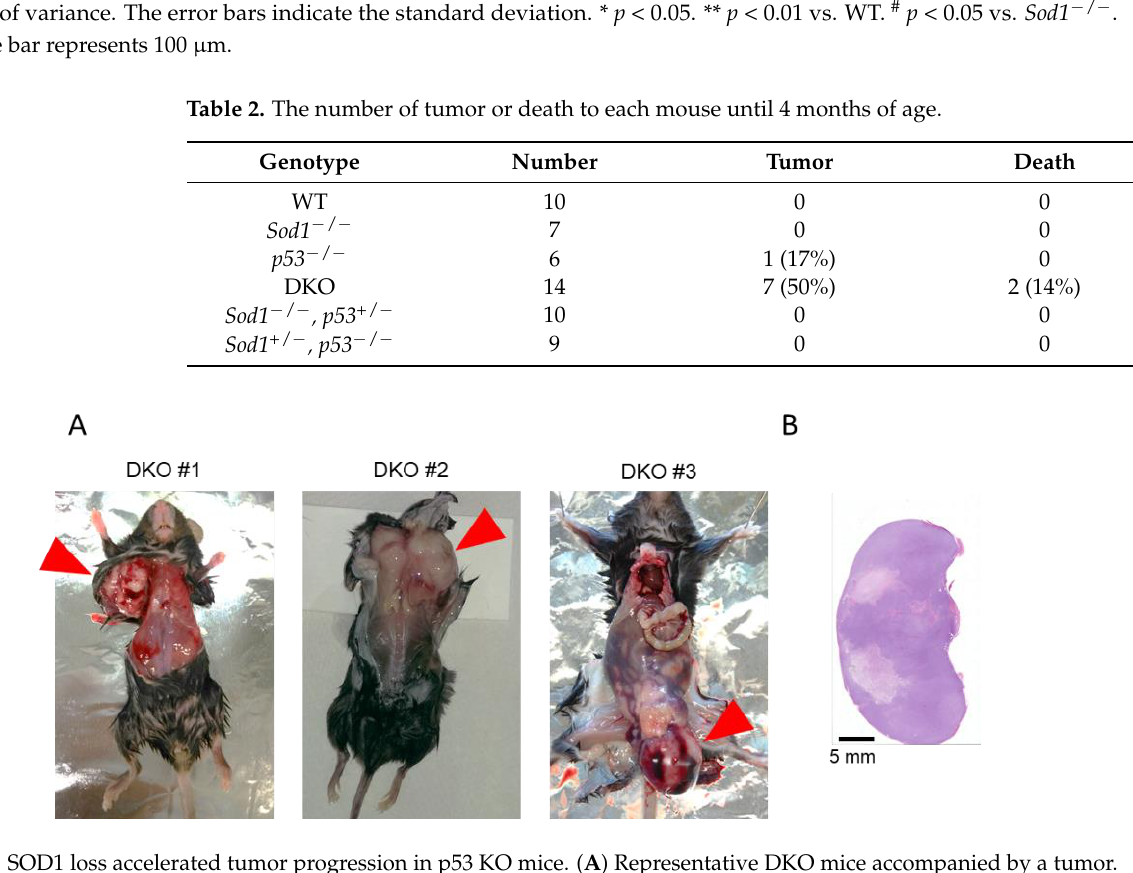
Figure 3. SOD1 loss accelerated tumor progression in p53 KO mice. ( A ) Representative DKO mice accompanied by a tumor. The red arrows indicate the tumor. ( B ) Hematoxylin and eosin staining of the tumor from DKO